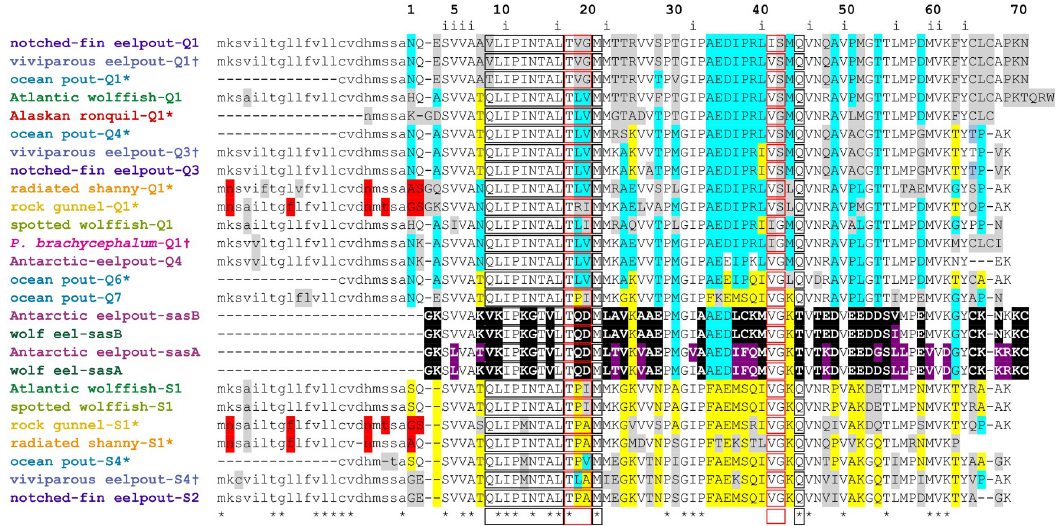
Fig 2. Alignment of a representative selection of known type III AFP sequences. Sequences are named using the common name for each species except for P . brachycephalum . Names are colored as in Fig 1 with an asterisk indicating the sequences were obtained by PCR in this study (S3 Table) and with a dagger for those assembled from the SRA database (S4 Table). They are numbered consecutively by species within the QAE (Q) or SP (S) group as they appear in S3 Fig. Residues conserved in all isoforms (sasA and B) are indicated with asterisks, variations characteristic of the QAE and SP groups are highlighted cyan and yellow respectively, with other variations in grey. Shared differences in the signal peptides of radiated shanny and rock gunnel are highlighted red. Black and red boxes show residues on the pyramidal- and prism-plane binding surfaces respectively [79]. Inward-facing residues (i) are indicated along the top. Residues unique to SAS are highlighted black with other differences within this group highlighted purple. Signal peptides are in lower case font. Dashes indicate gaps (internal) or incomplete sequence (at termini). The complete protein and nucleotide alignments are shown in S3 and S4 Figs,